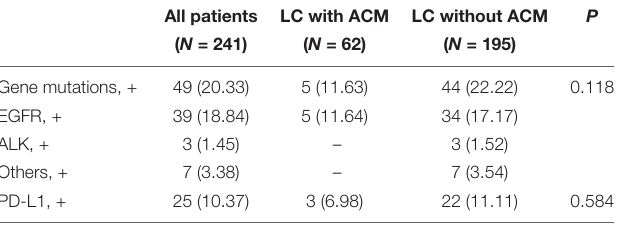
TABLE 2 | Gene mutations and PD-L1 characteristics in the NSCLC subgroup. All patients LC with ACM LC without ACM